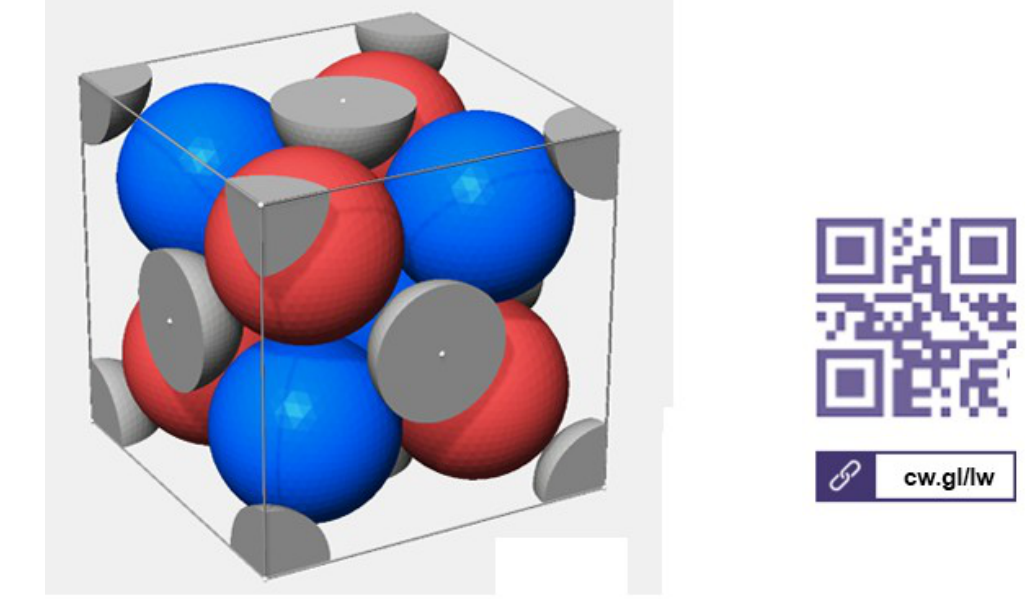
Figure 9. Fluorite structure with a link and QR code to access the online model. Source: [8]